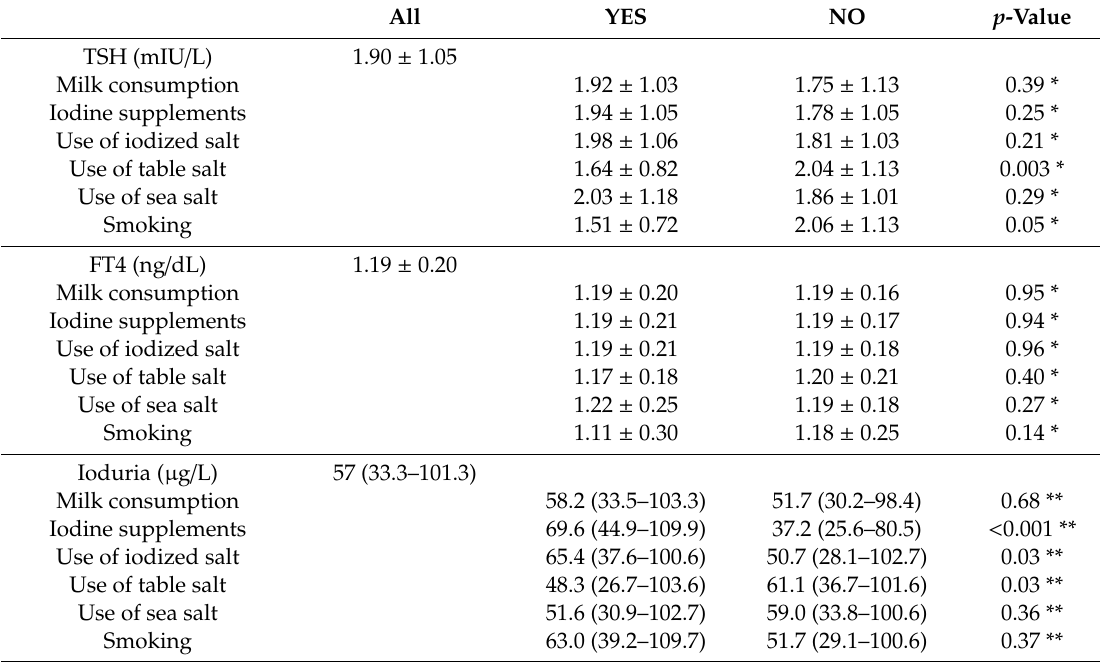
BMI: body mass index, * chi-squared test. Table 3. Clinical variables before week 12 of